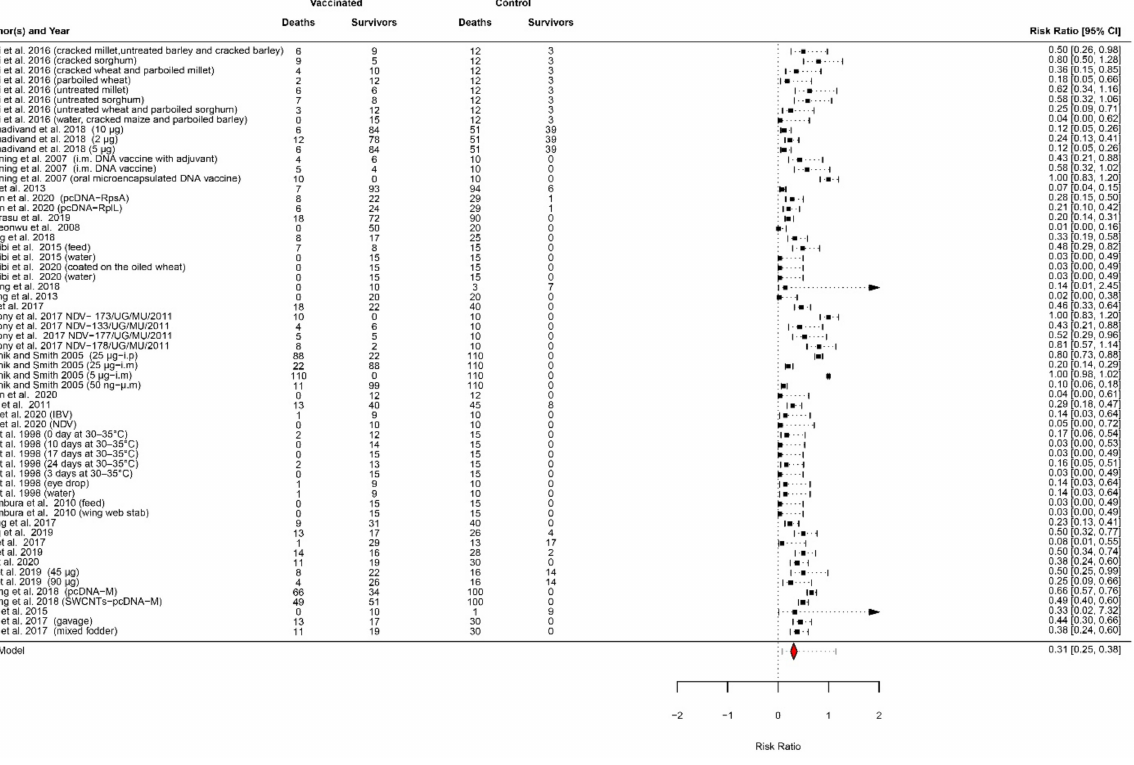
Figure 3. Forest plot of the risk ratio as a measure of vaccine efficacy (1-RR). Heterogeneity: I 2 = 95 (95% CI: 93–98), tau 2 = 0.44 (0.31–1.09), Q = 781.99, p -value <